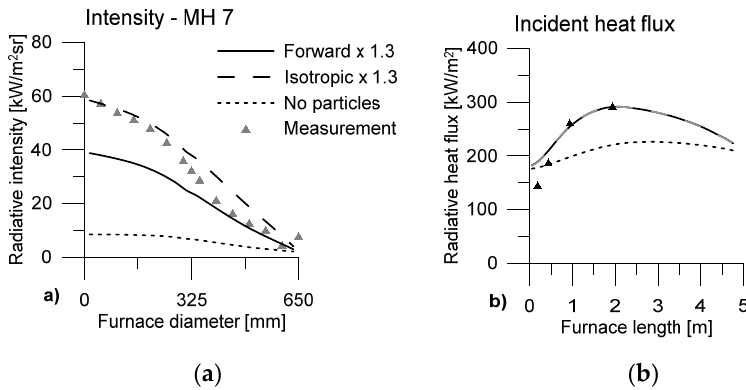
Figure 8. Measured and modelled ( a ) radiative intensity and ( b ) radiative heat flux showing the effects using an increased particle concentration with 30% as well as no particles.